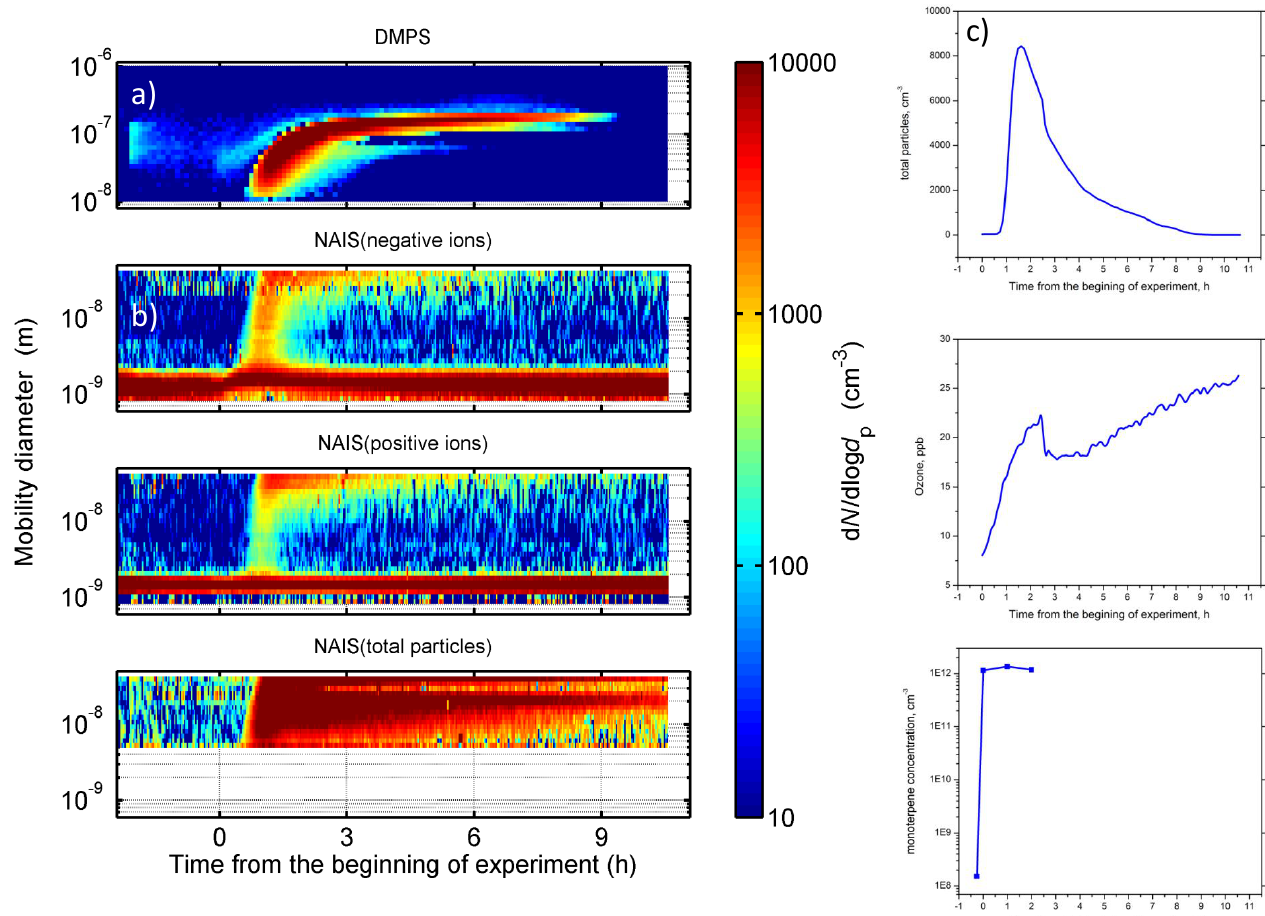
Fig. 4. Limonene event on 14 November 2008. (a) a DMPS plot showing all particles (neutrals + charged) from 10 to 1000nm. (b) a NAIS plot showing particles from 0.8 to 40nm. Top: negative particles; middle: positive particles; bottom: neutral + charged particles. c) Top: total number of particles per cm 3 , middle: Ozone concentration inppb , bottom: limonene concentration percm 3